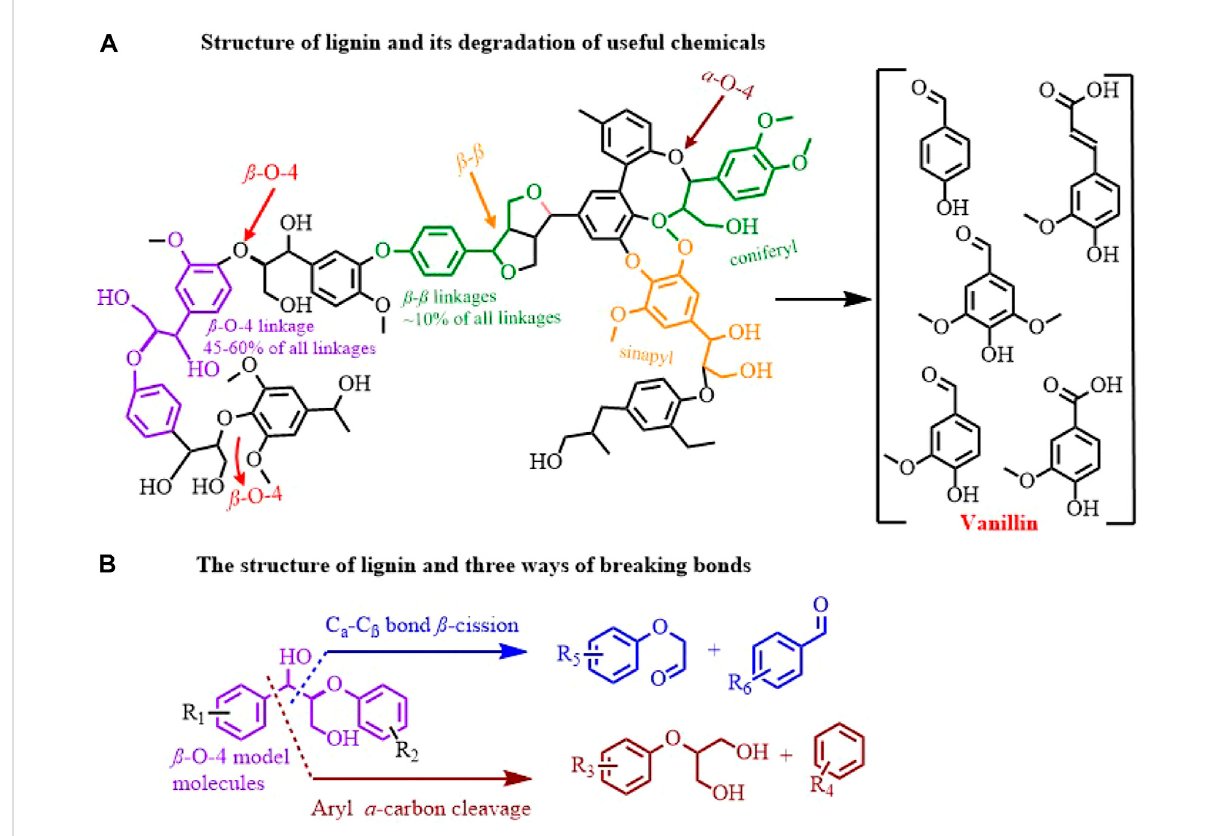
FIGURE 1 Schematic of the structure and bond cleavage position (A) , and fracture mode (B) of